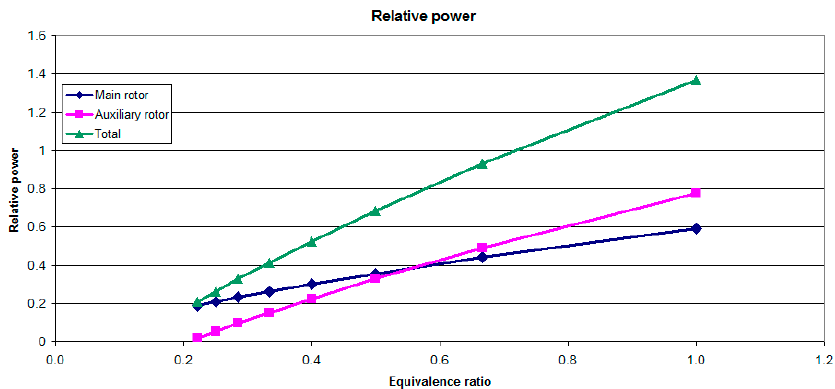
Figure 11. Estimated power of the main and auxiliary rotors and the total engine power at an inlet Mach number 2.5 in relation to the equivalence ratio.